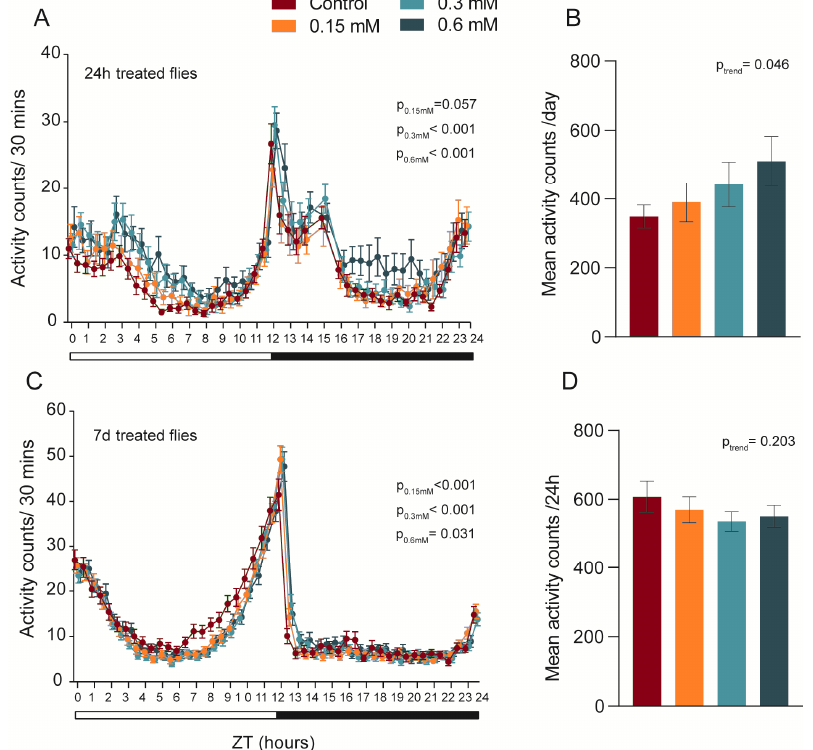
Figure 2. NMDA inhibition effects on general activity and circadian rhythm. ( A ) Flies treated acutely demonstrated an increase in general activity, mostly during the light period. ( B ) These effects were significantly dose-dependent. ( C ) Chronic MK-801 intake, on the other hand, induced a significant reduction in general locomotion, mainly during the last hours of the light phase. ( D ) However, it was not enough to present differences in mean daily activity (right panel). For daily activity counts analysis and dose–response average activity analysis (24 h intake: n [control/ 0.6mM] = 26, n [0.15mM] = 25, n [0.3mM] = 29; 7 d intake: n [control] = 76 n [0.15mM] = 65, n [0.3mM] = 87, n [0.6mM] = 82), two-way ANOVA and one- way ANOVA with linear trend post hoc were applied, respectively. Values are shown as mean ± SEM.